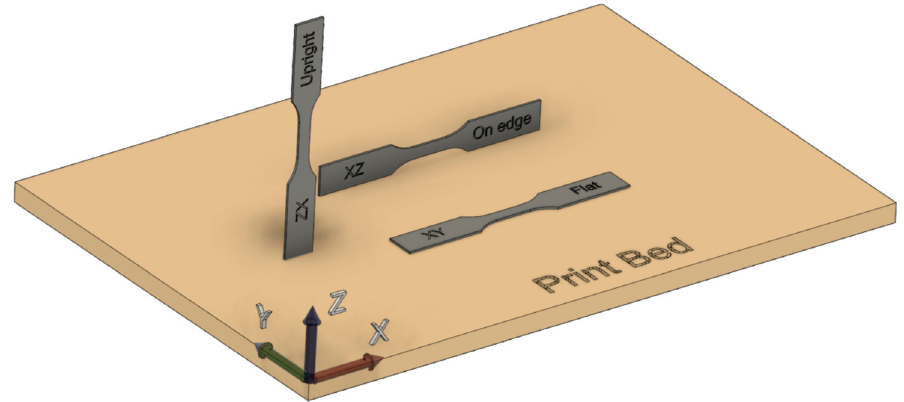
Figure 1. Printed specimen and predefined build orientations.